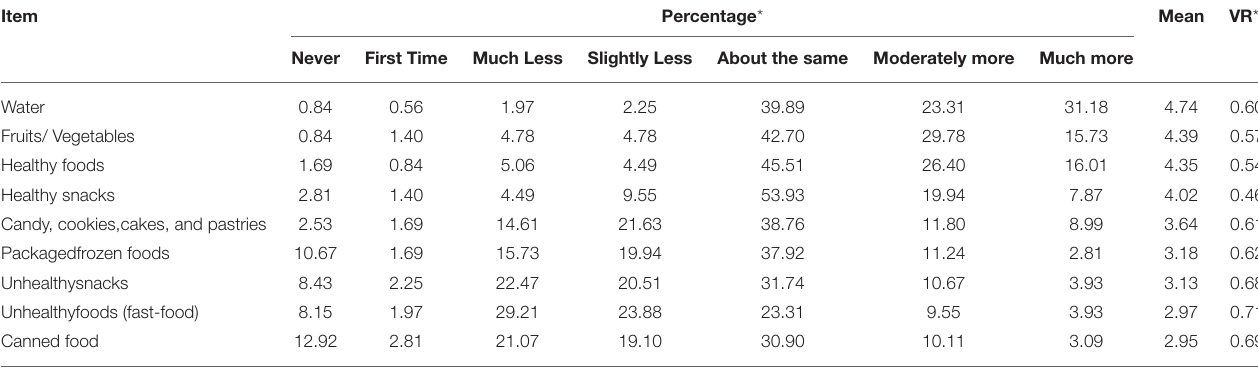
TABLE 3 | Eating and drinking patterns during the COVID-19 pandemic ( n = 356).